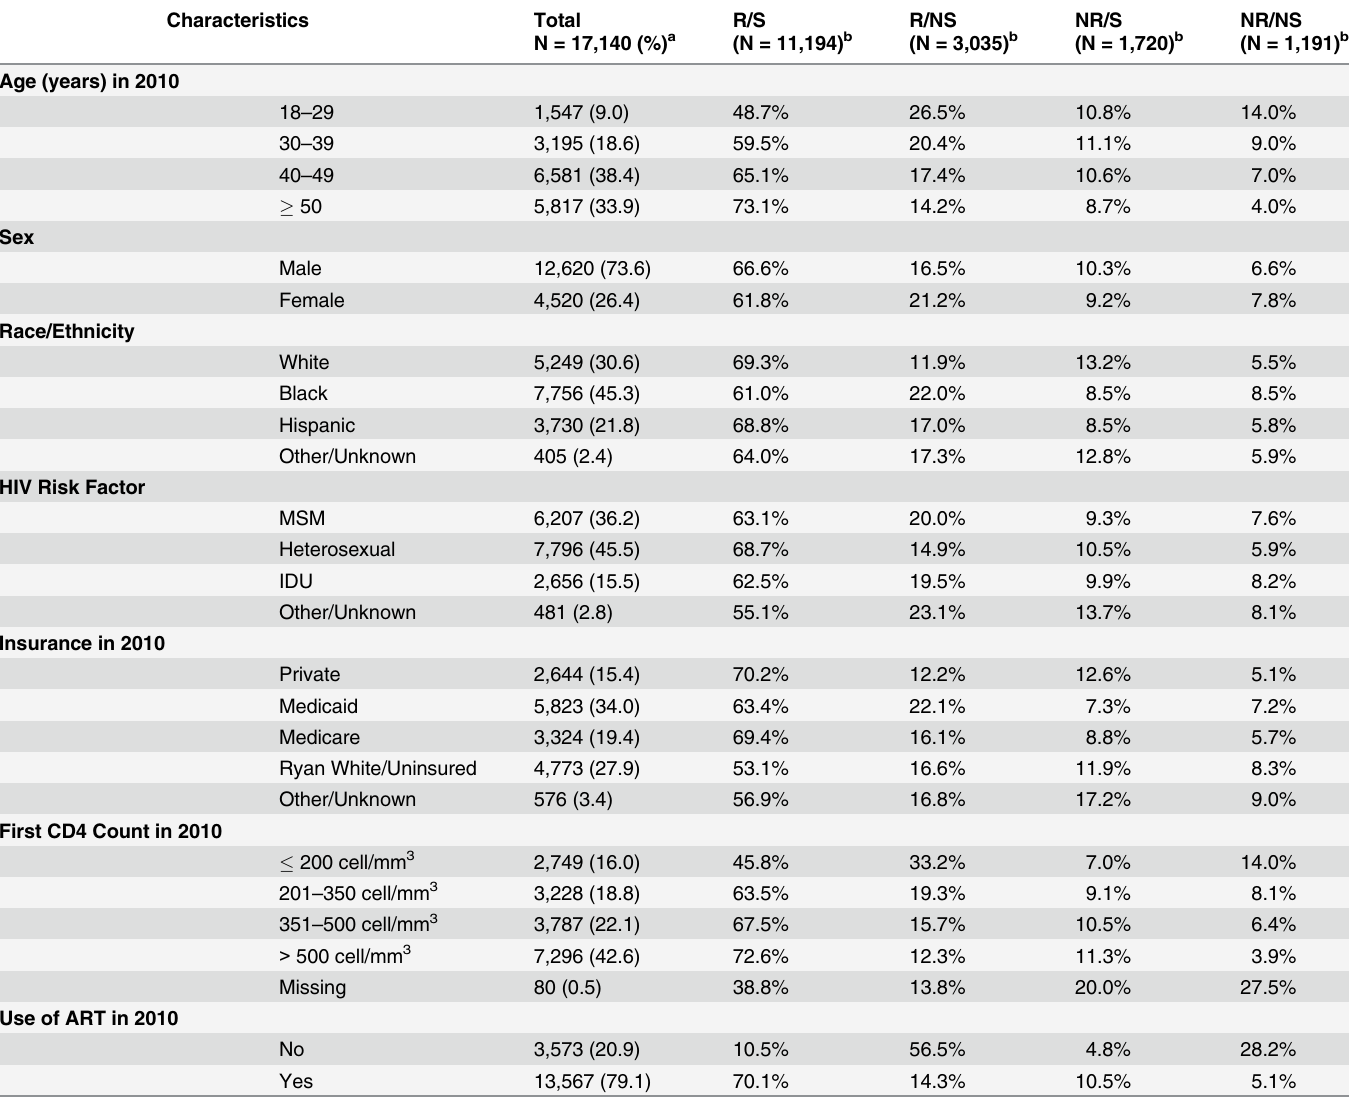
Table 1. Demographic and Clinical Characteristics of the Sample and Association with Retention/Suppression Status in 2010.